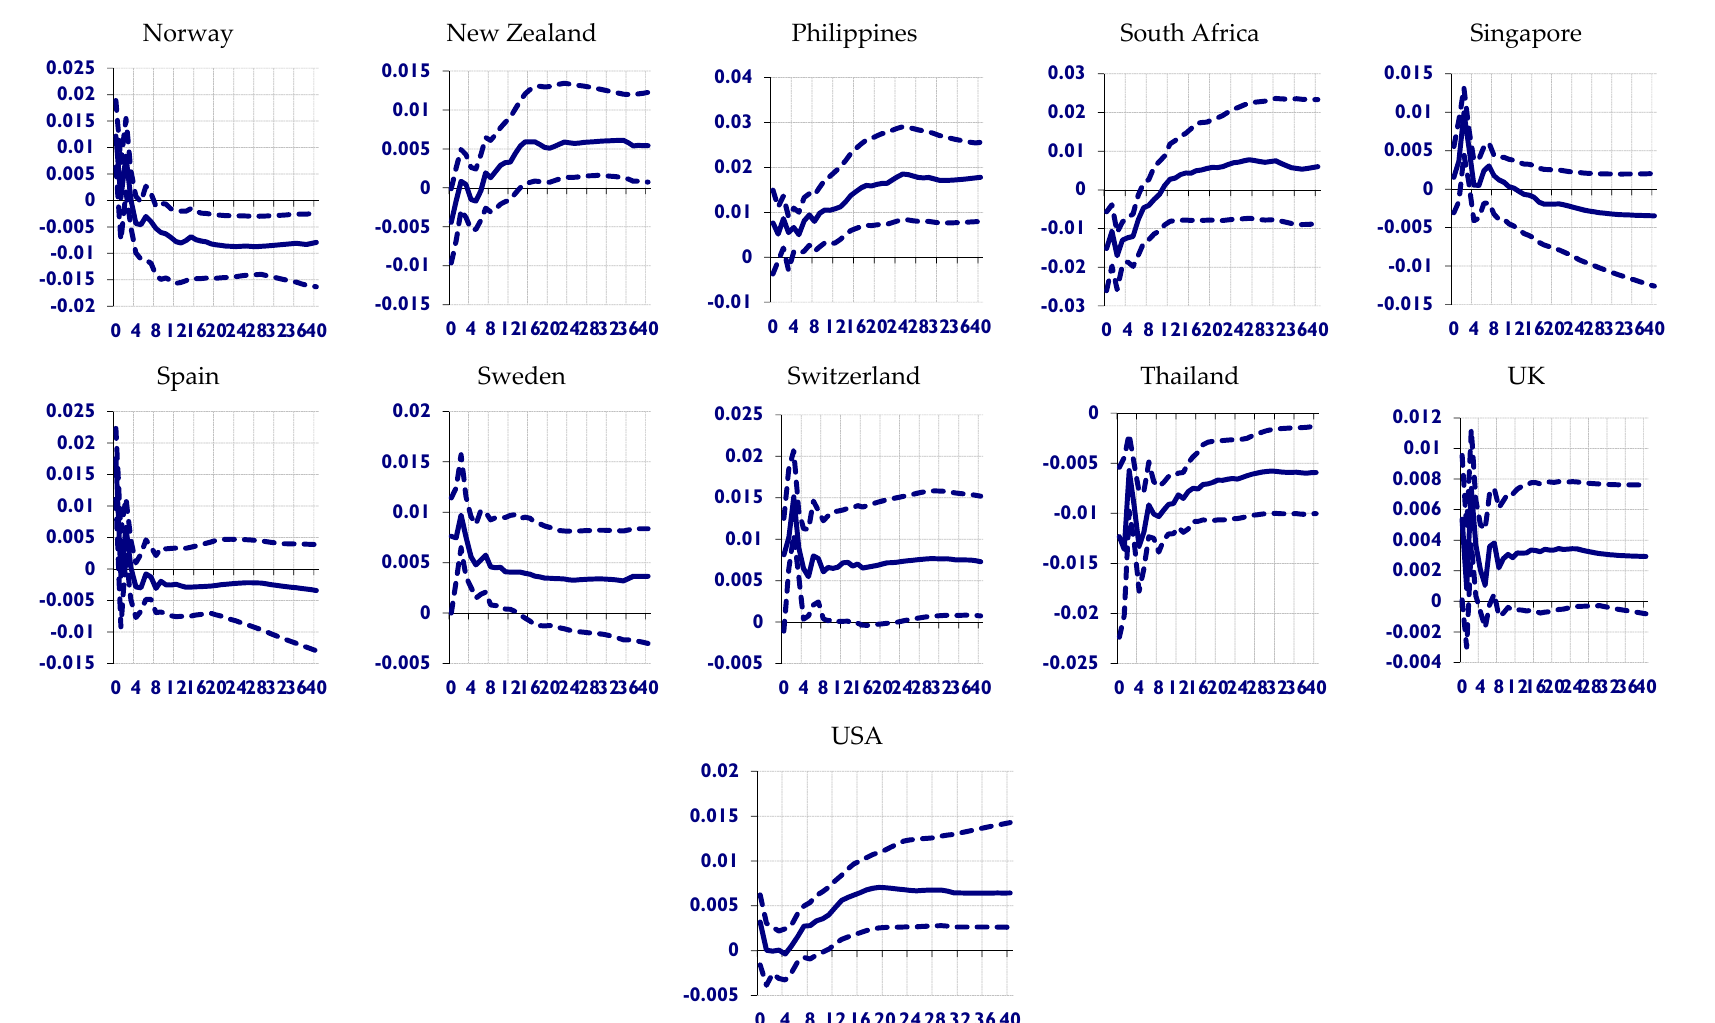
Figure 1. Country-level Impulse Response Functions of Real Equity Prices to a One Standard Deviation Positive Global Technology Shock (GTS − 164).